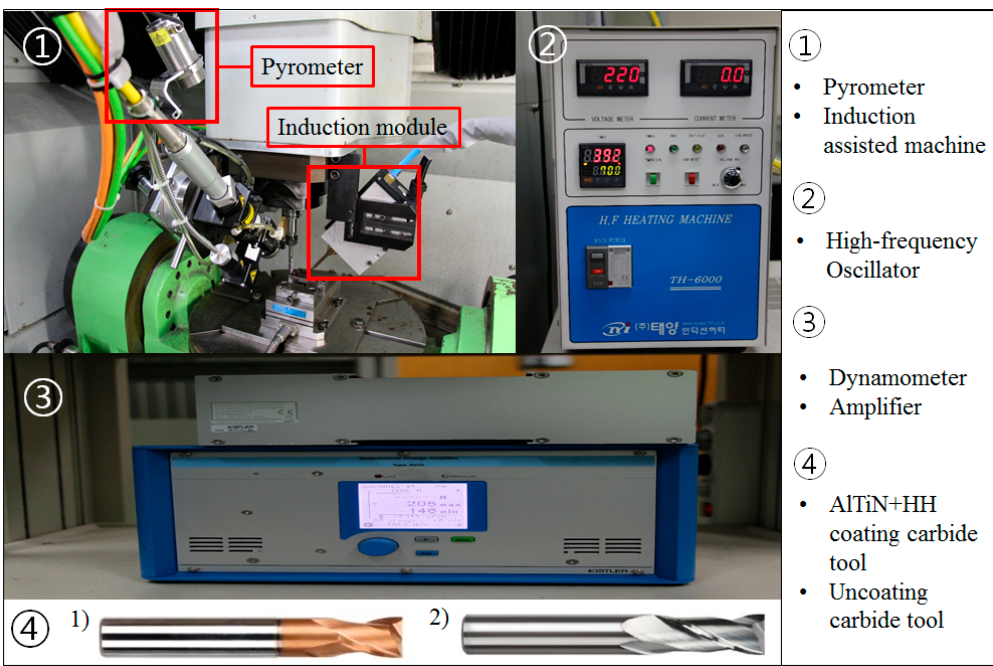
Figure 2. The distance between the tool, coil and workpiece.